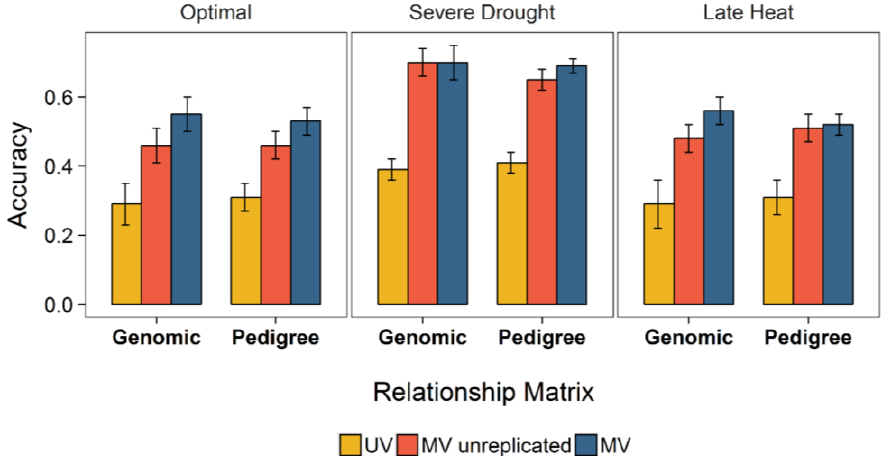
Figure 8. Accuracy of univariate and multivariate genomic prediction models for yield. Comparison of ordinary univariate pedigree and genomic selection model accuracies with those of multivariate pedigree and genomic selection models incorporating either replicated or unreplicated secondary trait data in optimal, severe drought, and late heat environments. (UV = univariate; MV = multivariate). Adapted from Rutkoski et al., 2016 [115].